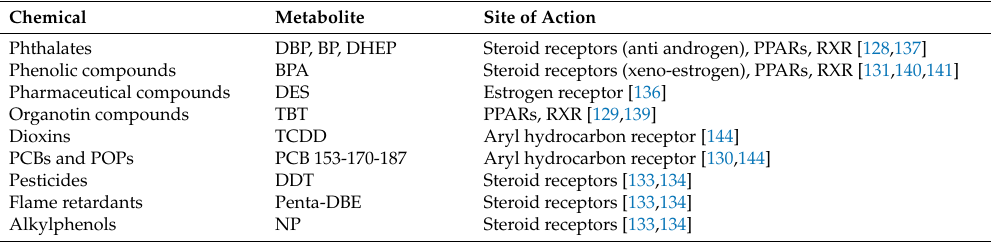
Table 1. Principal obesogenic endocrine disrupting chemicals (EDCs) and the site of action. Chemical